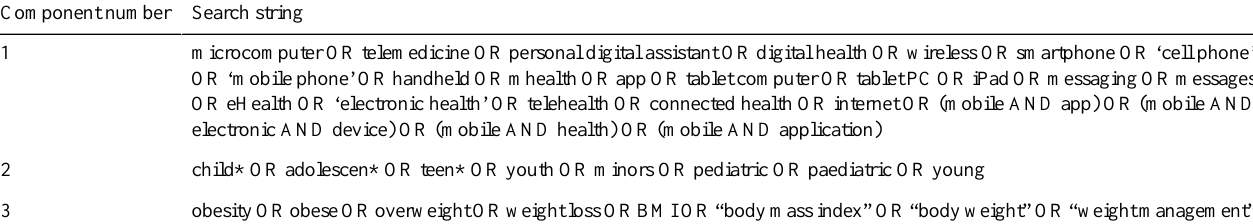
Table 1. Search strategy.